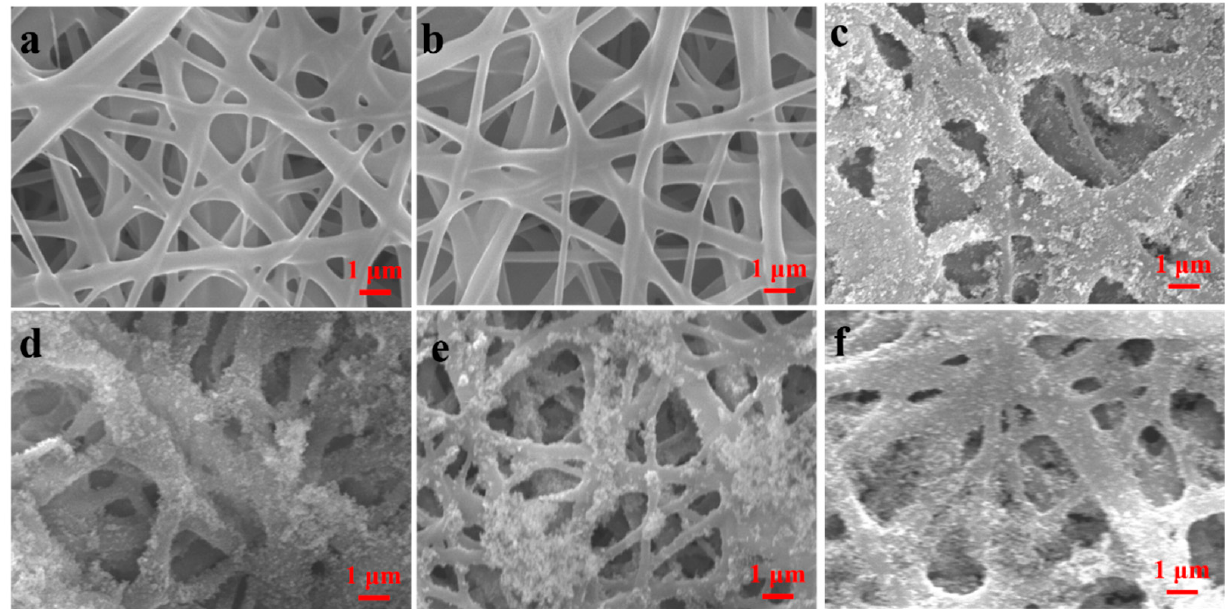
Figure 2. SEM images of ( a ) the SBS fibrous membrane, ( b ) the SBS/PDA fibrous membrane and ( c )–( f ) the SBS/PDA/SiO 2 fibrous membrane with SiO 2 NPs concentrations of ( c ) 0.5 wt%, ( d ) 1.0 wt%, ( e ) 2.0 wt% and ( f ) 4.0 wt%, respectively.